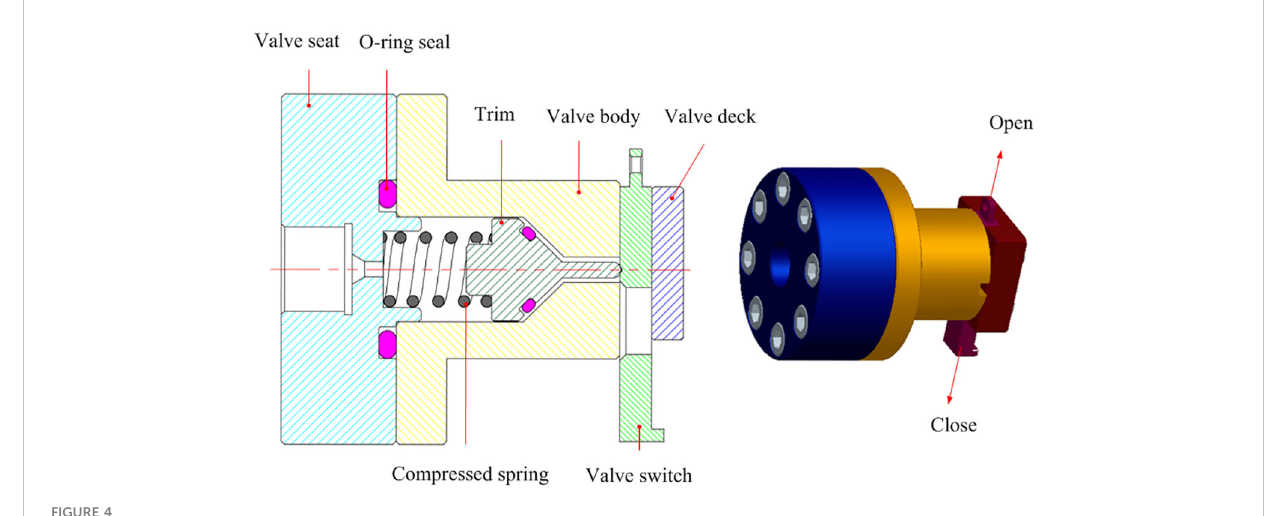
FIGURE 4 Structure scheme of the drain